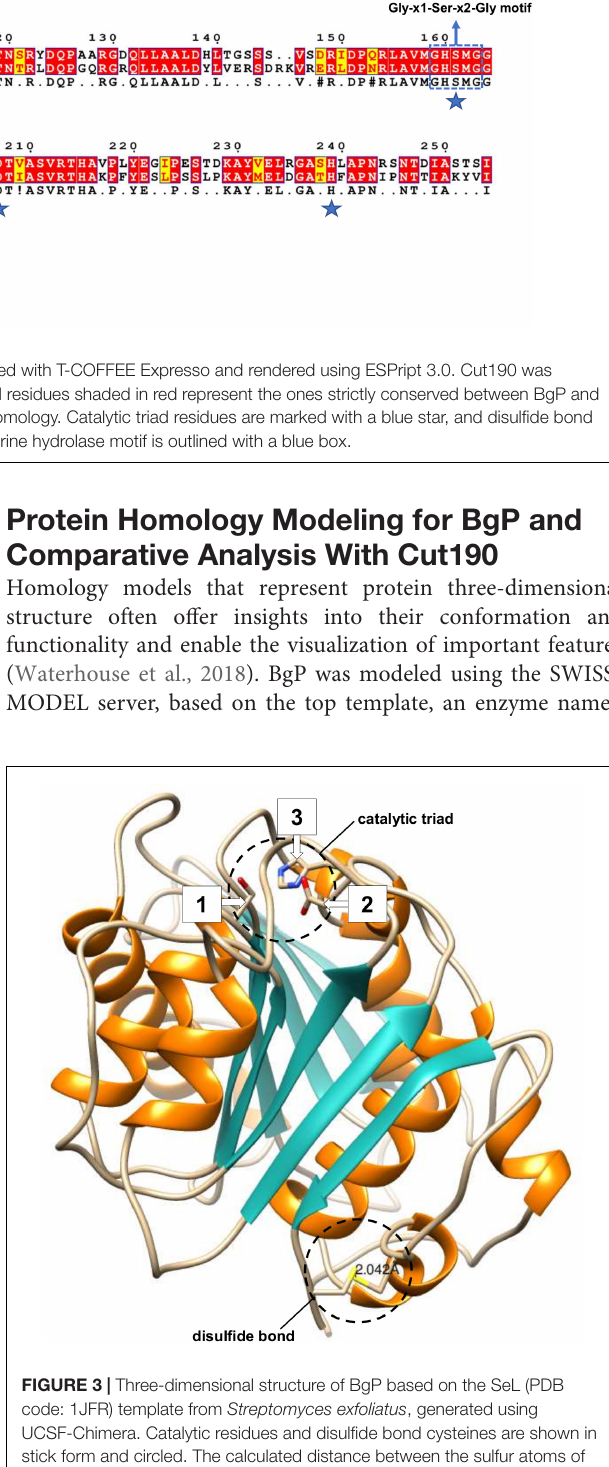
Frontiers in Microbiology |